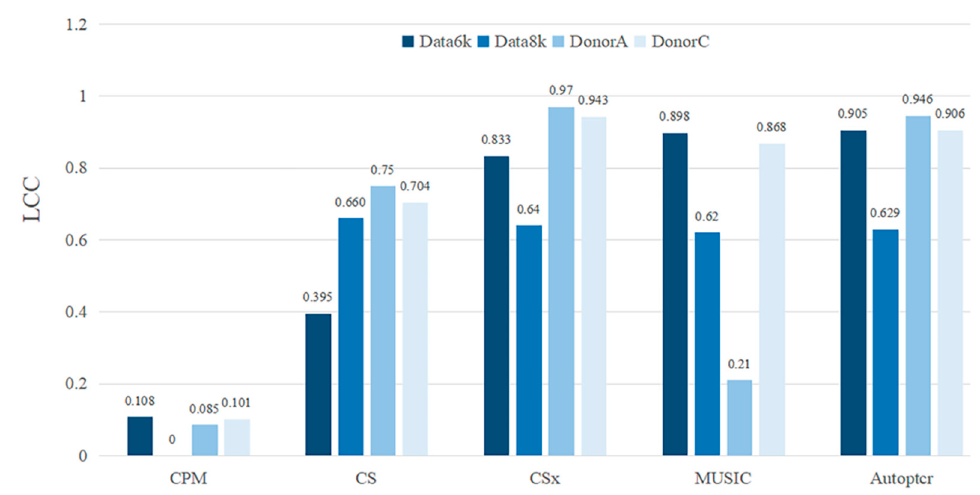
Figure 4. LCC of CPM, CS, CSx, MusiC, and Autoptcr on four datasets.